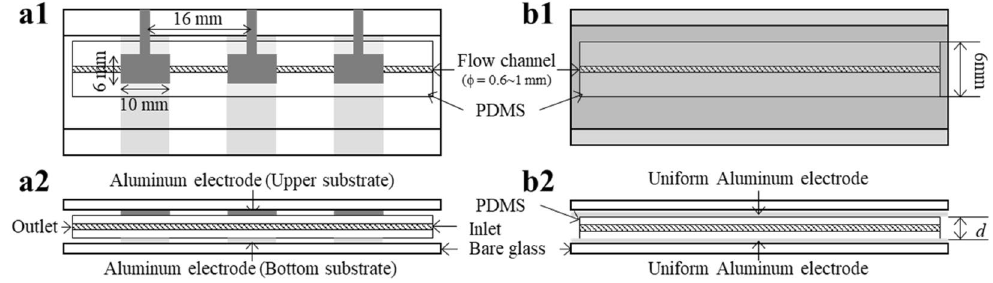
Figure 7. The patterned electrode and the uniform electrode. ( a1 ) Schematic top view and ( a2 ) schematic side view of the patterned electrode. We deposited three aluminum electrodes with dimensions of 6 mm × 10 mm on the upper glass substrate with intervals of 16 mm. We deposited three aluminum electrodes whose width was 10 mm on the lower glass substrate with an interval of 16 mm. ( b1 ) Schematic top view and ( b2 ) schematic side view of uniform